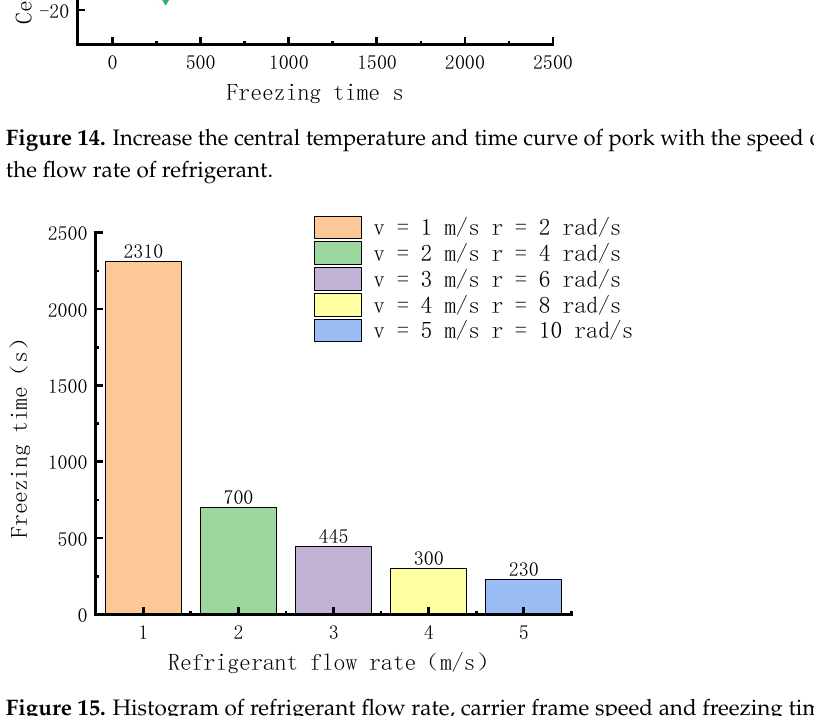
Figure 16. R efrigeration efficiency change curve with the increase of basket speed and refrigerant flow rate. Table 7 shows the time taken (s) for the center of the pork to reach –18 °C at different combinations of refrigerant flow rate and rotational speed. Figure 17 shows the three ‐ di ‐ mensional curved surface of the two variables of freezing speed, flow rate and rotational speed The following conclusions can be drawn from the comparative study presented above when combined with the information in Table 7 and Figure 17: (1) increasing the refrigerant carrier’s flow rate can reduce the freezing time, but the efficiency improvement is minimal, and the effect of the freezing is clearly uneven; (2) Adding a rotating device can significantly reduce the freezing time, increase the freezing efficiency, and signifi ‐ cantly increasing the freezing uniformity.